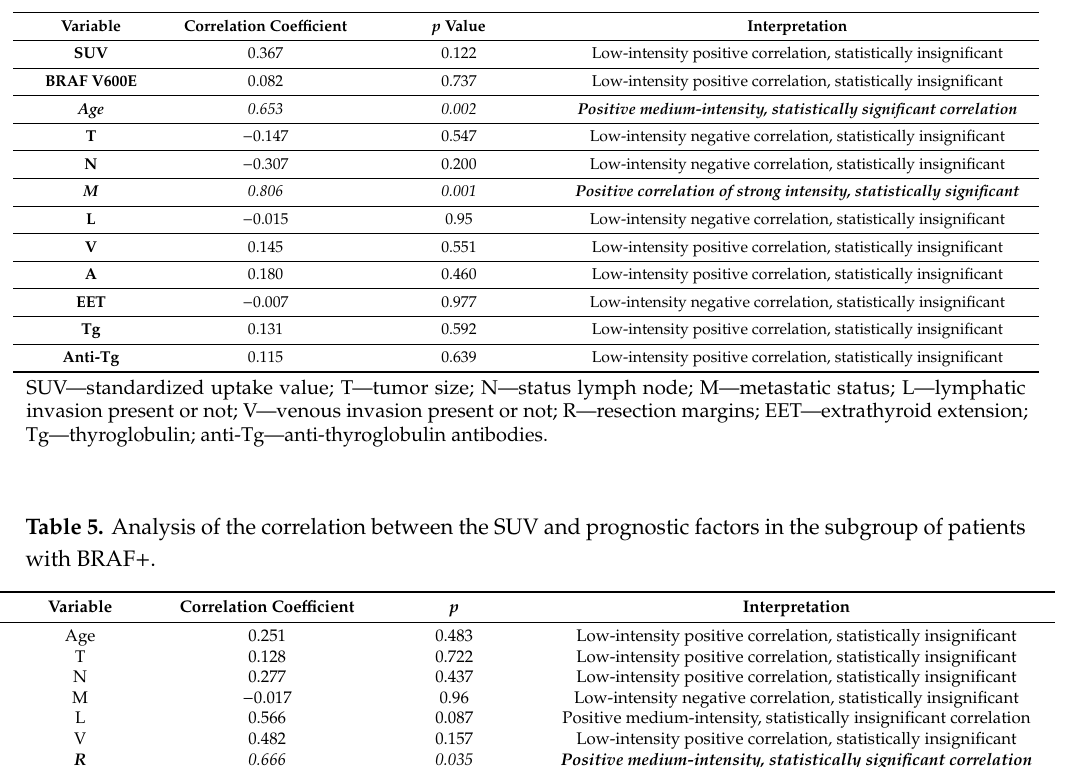
Table 4. Analysis of the correlation between the stage of the disease and prognostic factors.